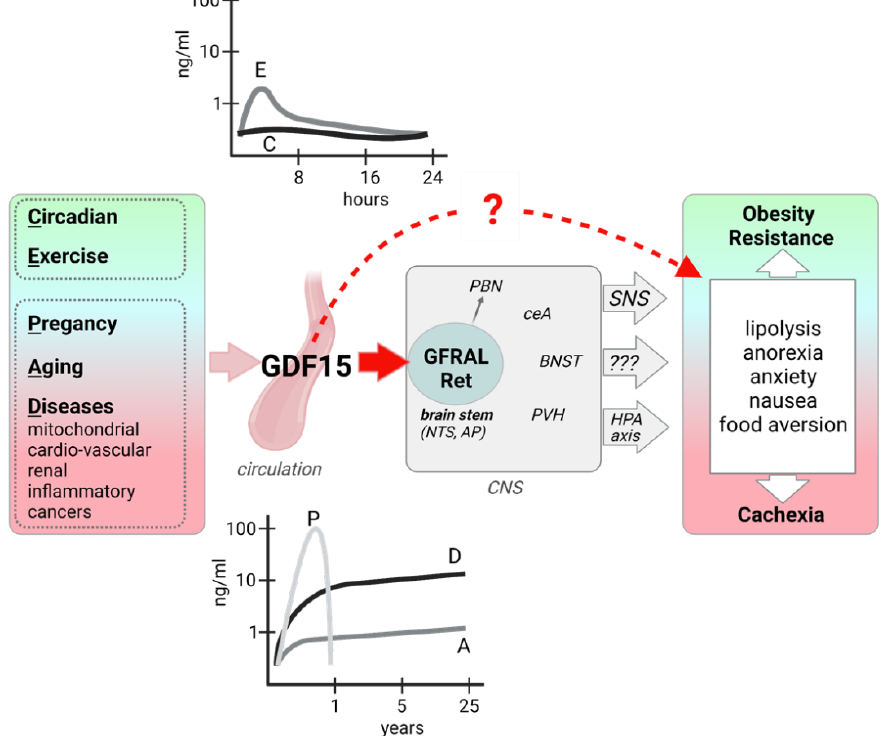
Figure 1. GDF15 induction, signaling, and metabolic effects. GDF15 expression and secretion from various organs and tissues is induced in different physiological and pathophysiological states, leading to highly variable circulating GDF15 levels. GFRAL, the exclusive receptor for GDF15 is expressed in neurons of the AP/NTS of the hindbrain, which directly project to the PBN and also activate other brain areas. Efferent signaling includes an increased sympathetic outflow and possibly an activation of the HPA axis. Human evidence also points to a peripheral, direct action of GDF15 on adipose tissue lipolysis. Metabolic and behavioral outcomes of GDF15 signaling can be beneficial or detrimental, possibly depending on the magnitude and duration of the GDF15 signaling. AP: area postrema; BNST: bed nucleus of the stria terminalis; ceA: central Amygdala, HPA: hypothalamic-pituitary-adrenal; NTS: nucleus tractus solitarius; PBN: parabrachial nuclei; PVH: paraventricular nucleus of the hypothalamus; SNS: sympathetic nervous system. Figure created with BioRender.com (28 September 2021).